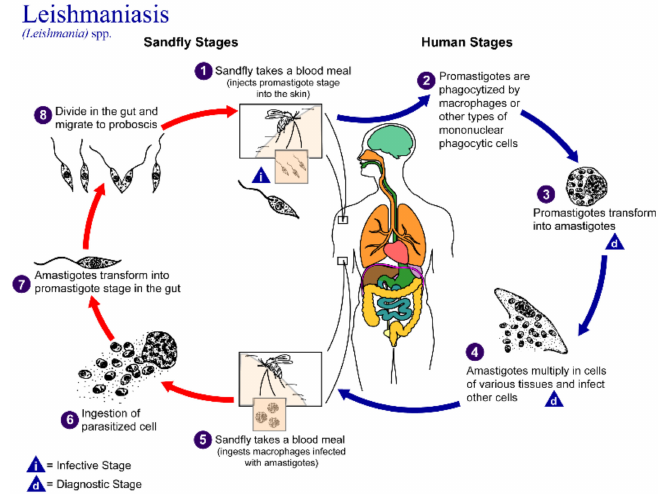
Figure 1. Life cycle of the Leishmania parasite. Reprinted with permission from https://www. cdc.gov/parasites/leishmaniasis/biology.html. CDC/Alexander J. da Silva, Ph.D. (accessed on 17 October 2022)